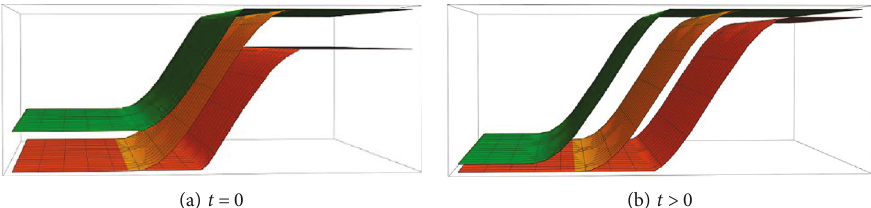
Figure 2: The subsolutions (red) and supersolutions (green) given in (62) – (63) by a modi fi cation of the planar wave U (yellow) in ℝ 2 . If the initial data v 0 ð z Þ is close enough to U so that v 0 ð z Þ is between sub- and supersolutions at t = 0 , the solution v ð z , t Þ stays between them for all t > 0 . The fact that both v and U are trapped by the sub- and supersolutions whose di ff erence is su ffi ciently small for all time t > 0 guarantees the stability of U